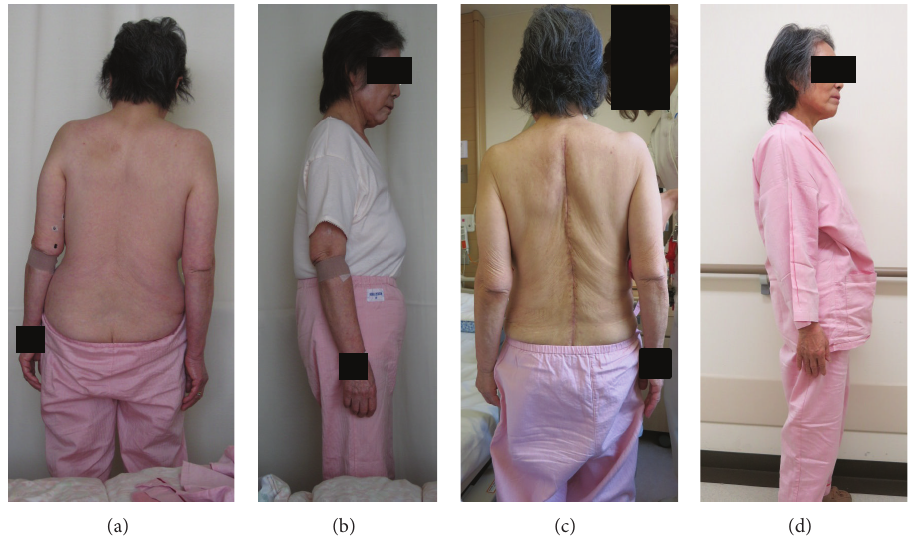
Figure 5: Posture before surgery and after surgery in Case 2. Posterior-anterior view (a) and lateral view (b) before surgery, and posterior- anterior view (c) and lateral view (d) after